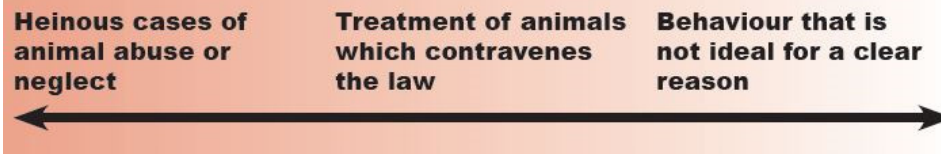
Figure 1. The Animal Harm